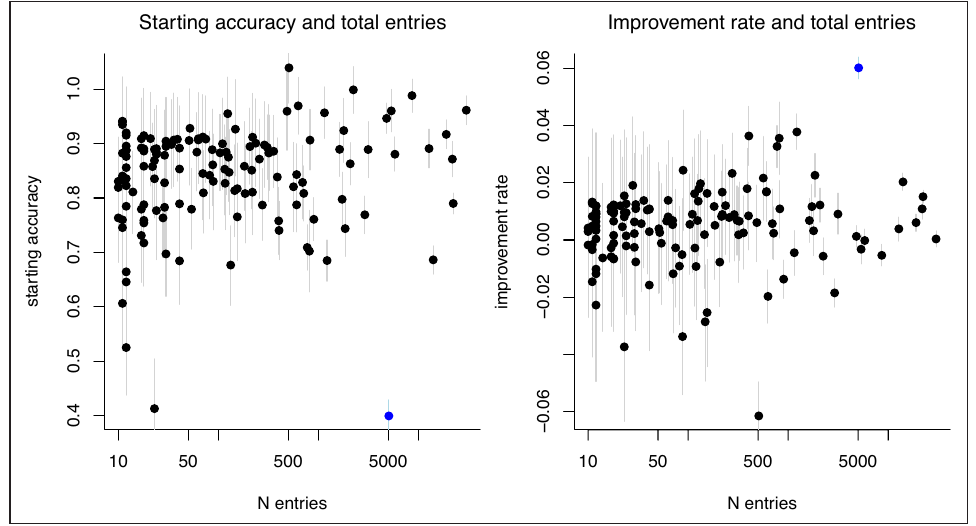
Figure 10: Starting accuracies (left panel) and improvement rates (right panel measured as OSA-improvement) against number of entries. Points indicate the mean estimate of the improvement rate or starting accuracy, and the vertical lines indicate 80 percent confidence